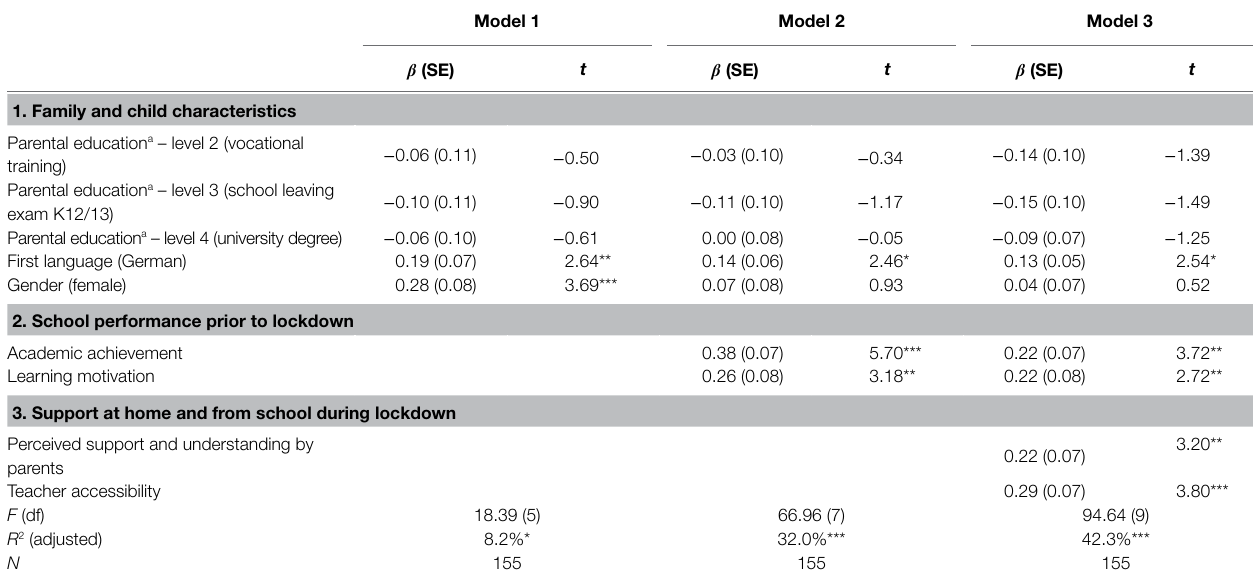
TABLE 3 | Regression models explaining coping with self-regulated distance